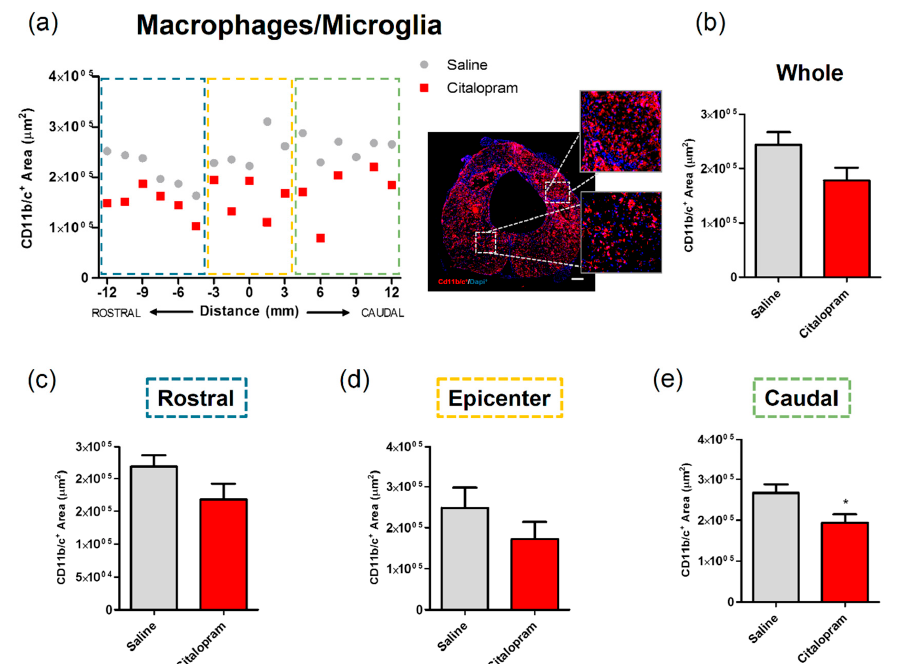
Figure 2. Impact of 7-day citalopram treatment on macrophages / microglia. ( a ) Distribution of CD11b / c + cell area along the rostro–caudal axis of the spinal cord; ( b ) quantification of the area occupied by CD11b / c + cells in the total analyzed area. Analysis of the spinal cord was then subdivided into ( c ) rostral, ( d ) lesion epicenter and ( e ) caudal areas of citalopram- ( n = 5) vs. vehicle-treated animals ( n = 6). Values shown as mean ± SEM; * p < 0.05. Scale bar: 200 µ m. Int. J. Mol. Sci. 2020 , 21 , x FOR PEER REVIEW